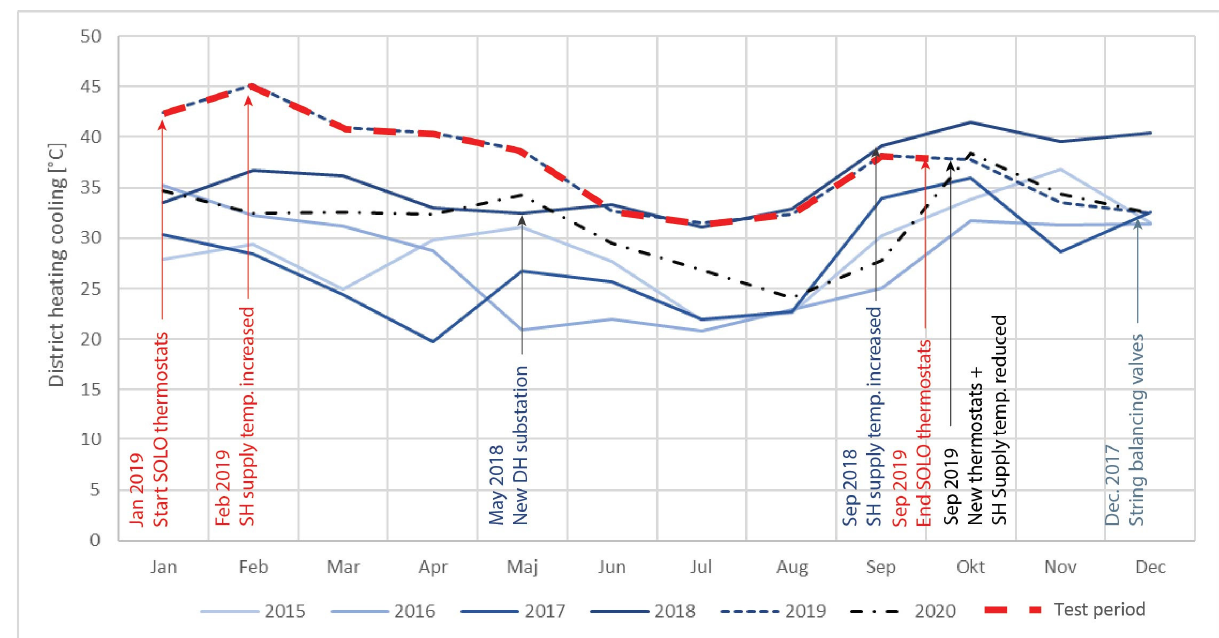
Figure 6. Monthly average district heating temperature difference during the past five years in Building A including timeline for adjustments.